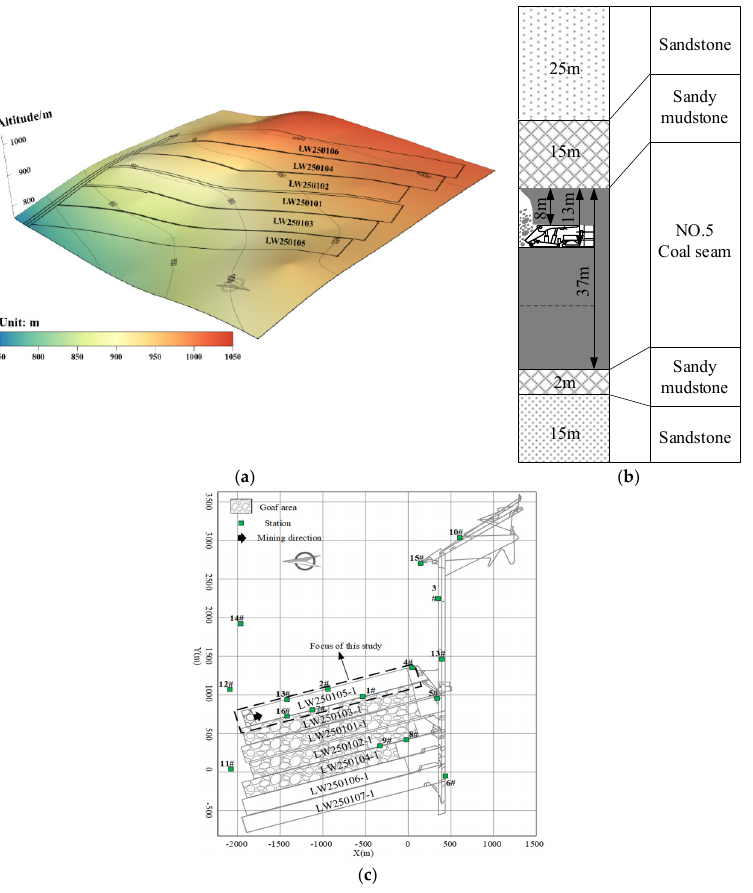
Figure 7. ( a ) LW250105-1 buried depth contour. ( b ) LW250106-1 layout and station distribution. ( c ) Stratigraphic column of LW250105-1.